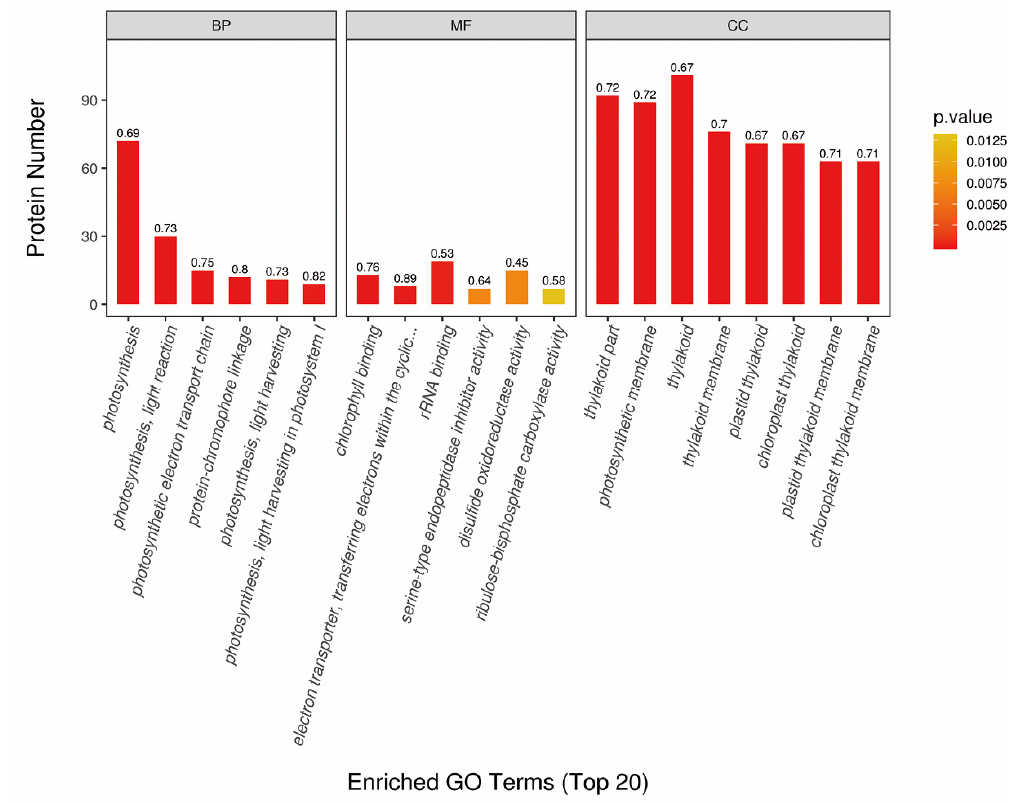
Figure7. GOfunctionalenrichmentanalysisofdi ff erentiallyaccumulatedproteins(DAPs)in OsCpn60 β 1 mutants compared with WT. The label at the top of the bar chart shows the enrichment factor (rich Factor ≤ 1), which represents the proportion of the number of DAPs annotated into a GO function category to the number of all identified proteins annotated into the GO function category. The color of the bar chart represents the significance of enriched GO functional classification, which is based on Fisher’s exact test to calculate the P value. BP, biological process; MF, molecular function; CC, cellular